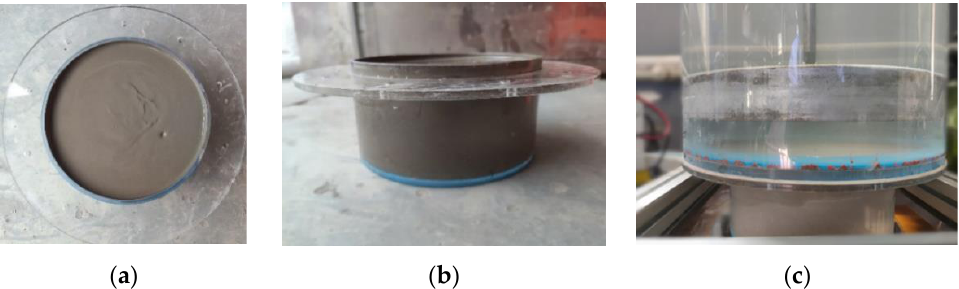
Figure 8. Photographs of simplified scour resistance tests. ( a ) Top view of specimen ( b ) Side view of specimen ( c ) Activation of erosion simulator.